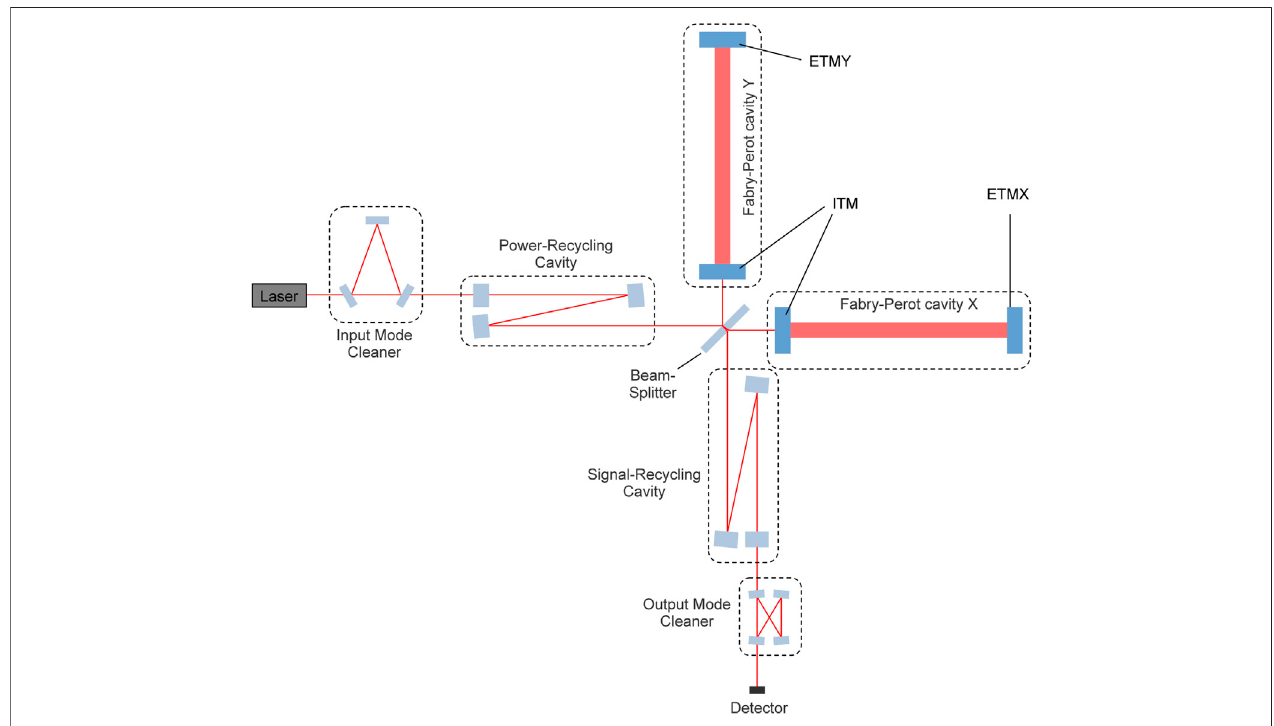
FIGURE 1 | Sketch of the basic optics and their principal alignment in the KAGRA detector. The ITM and ETM mirrors forming the Fabry-Perot cavities are (silica- tantala coated) sapphire single-crystals with their c-axis aligned parallel to the laser-beam path.